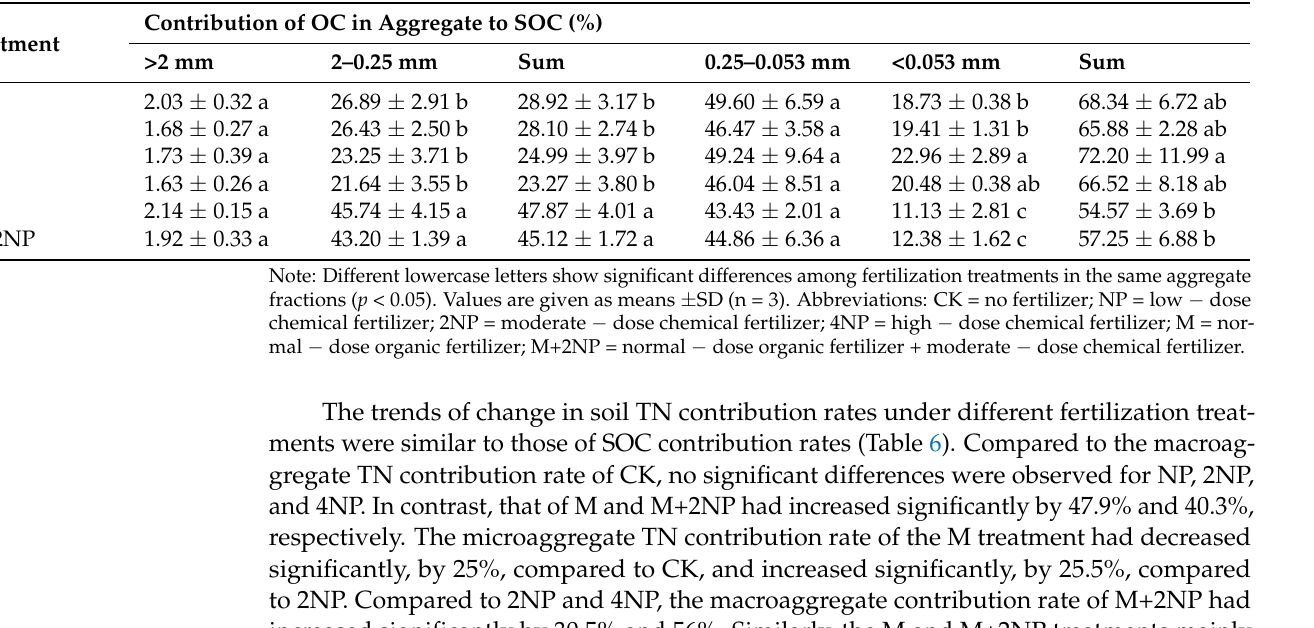
Table 5. Contribution of organic carbon in aggregate to total SOC under different treatments.